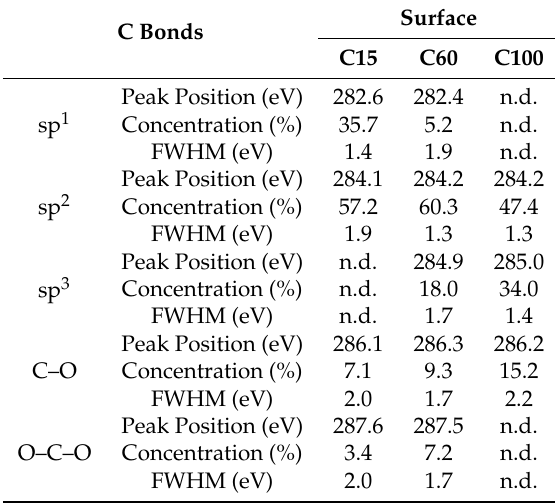
Table 2. X-ray photoelectron spectroscopy (XPS) data from the deconvolution of C1s high-resolution spectra of carbon